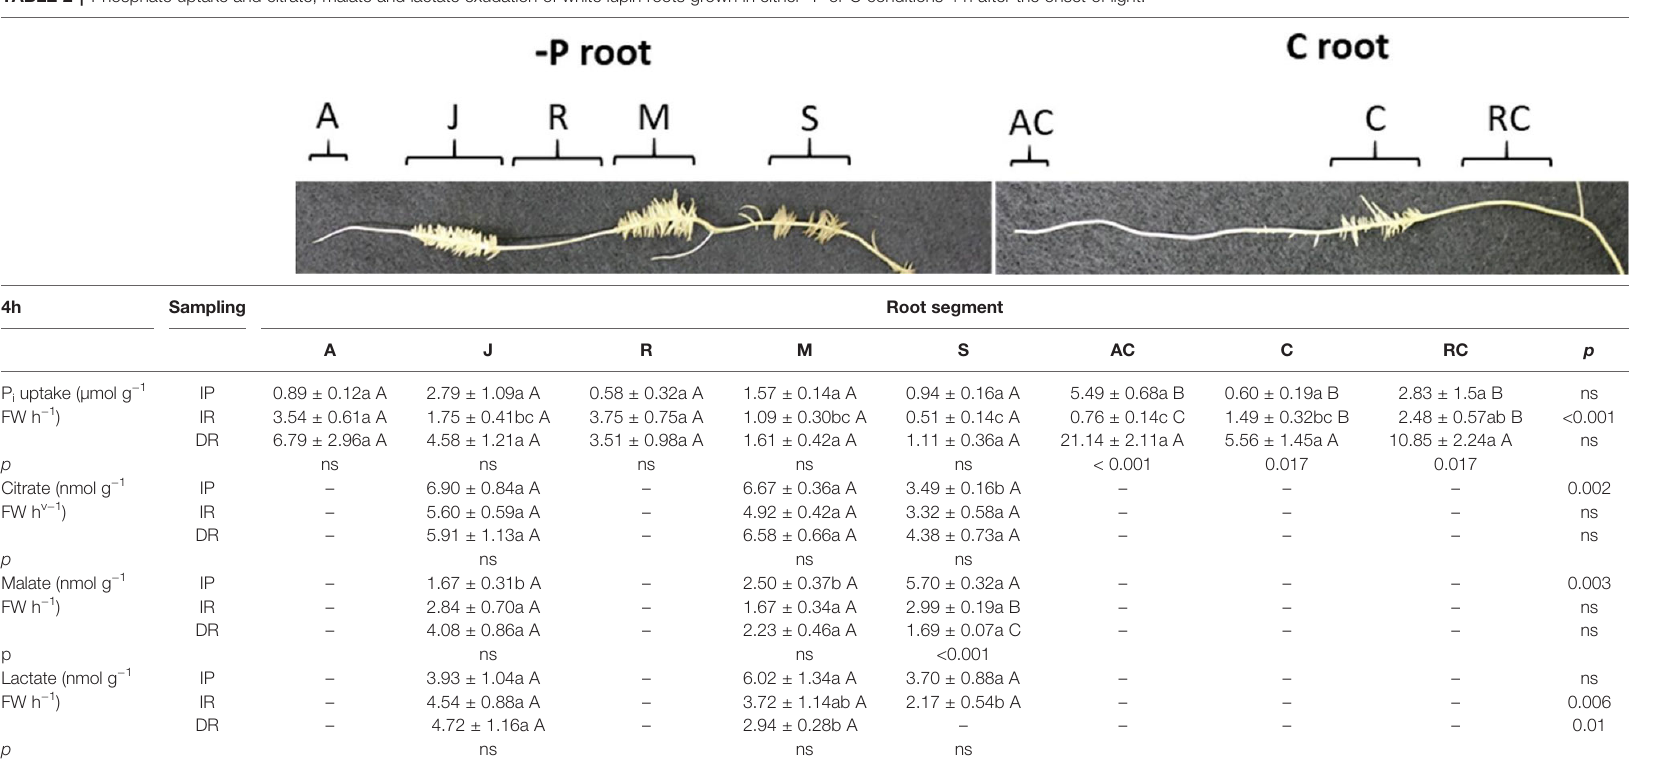
TABLE 2 | Phosphate uptake and citrate, malate and lactate exudation of white lupin roots grown in either -P or C conditions 4 h after the onset of